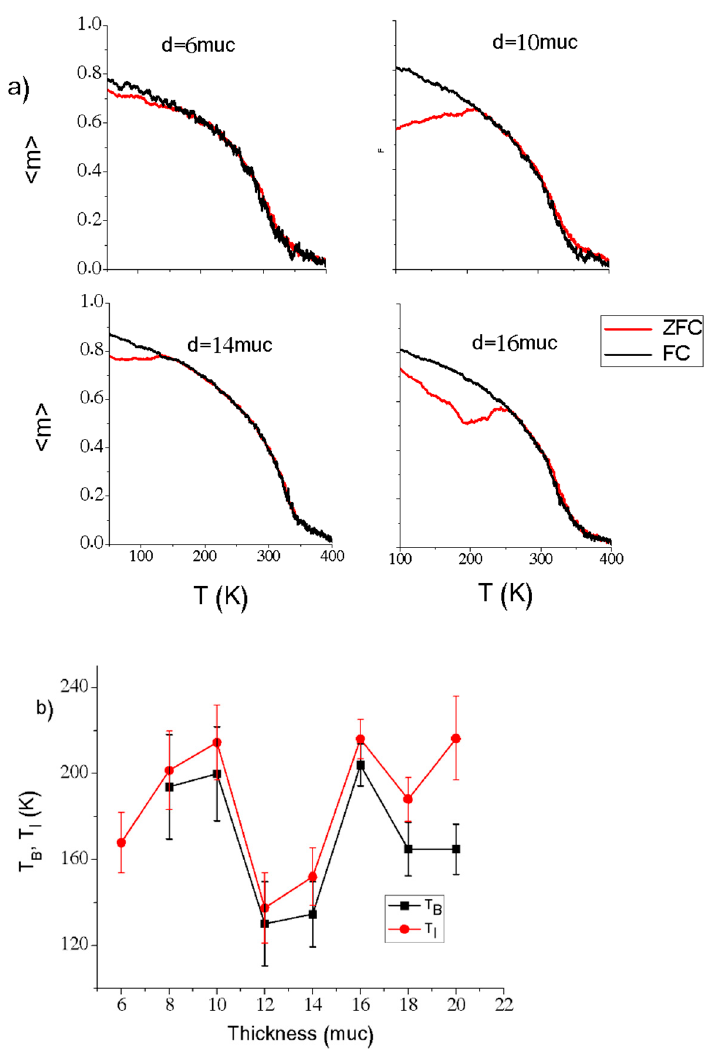
Figure 8. ( a ) Examples of FC–ZFC curves at different thicknesses, and ( b ) the blocking and irre- versibility temperatures as a function of the thickness.